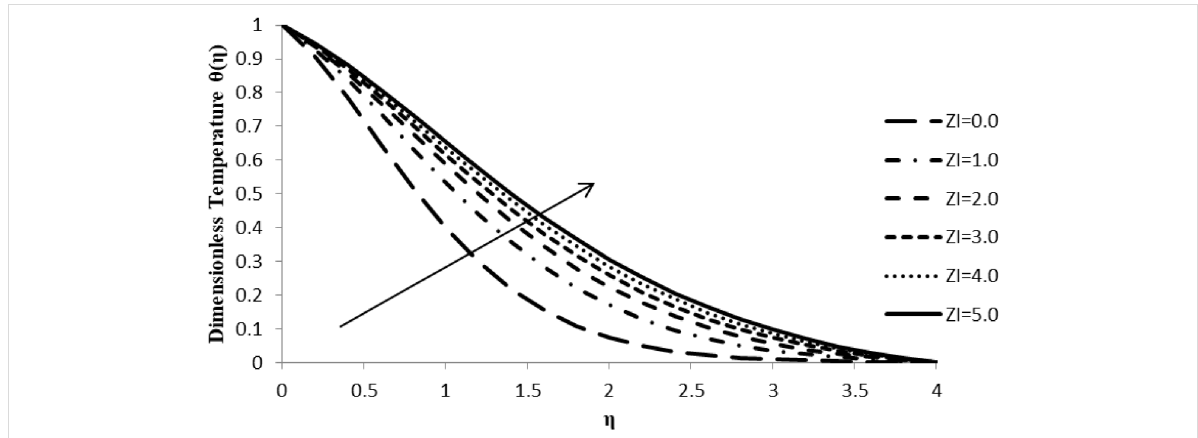
Figure 3: Influence of the slip parameter for liquids ξ on the temperature distribution θ ( η ) when n = 2.0, M = 0.0, Q = 0.0, Pr = 2.0, Nb = Nt = 0.5, Le = 5.0, and F w = 0.2.